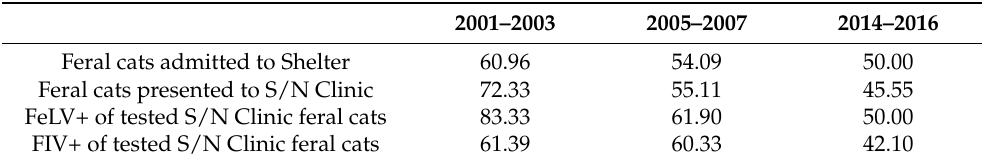
Table 7. Proportions of feral cats presented to PHS Shelter and S/N Clinic in the three periods from the four largest cities in San Mateo County